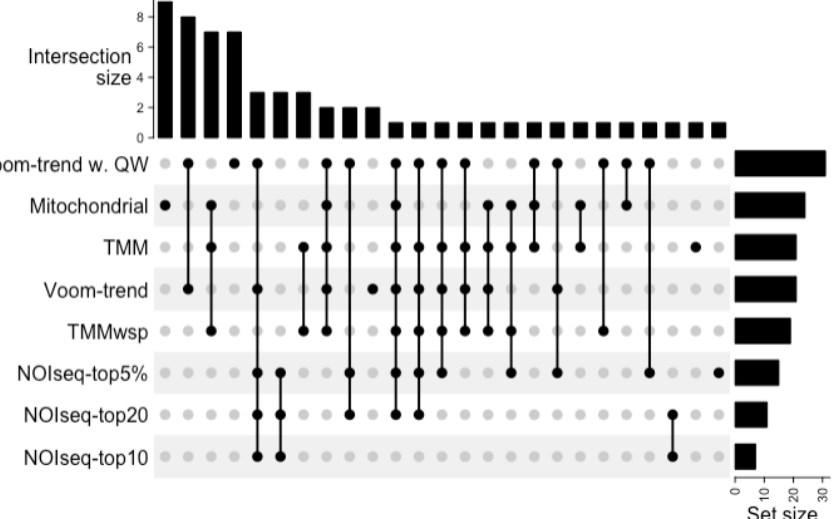
Figure 3. Upset plot showing the intersection between differentially expressed genes (DEGs) iden- tified by the benchmarked data handling methods (limited to the DEGs that are also identified in full-thickness biopsy).